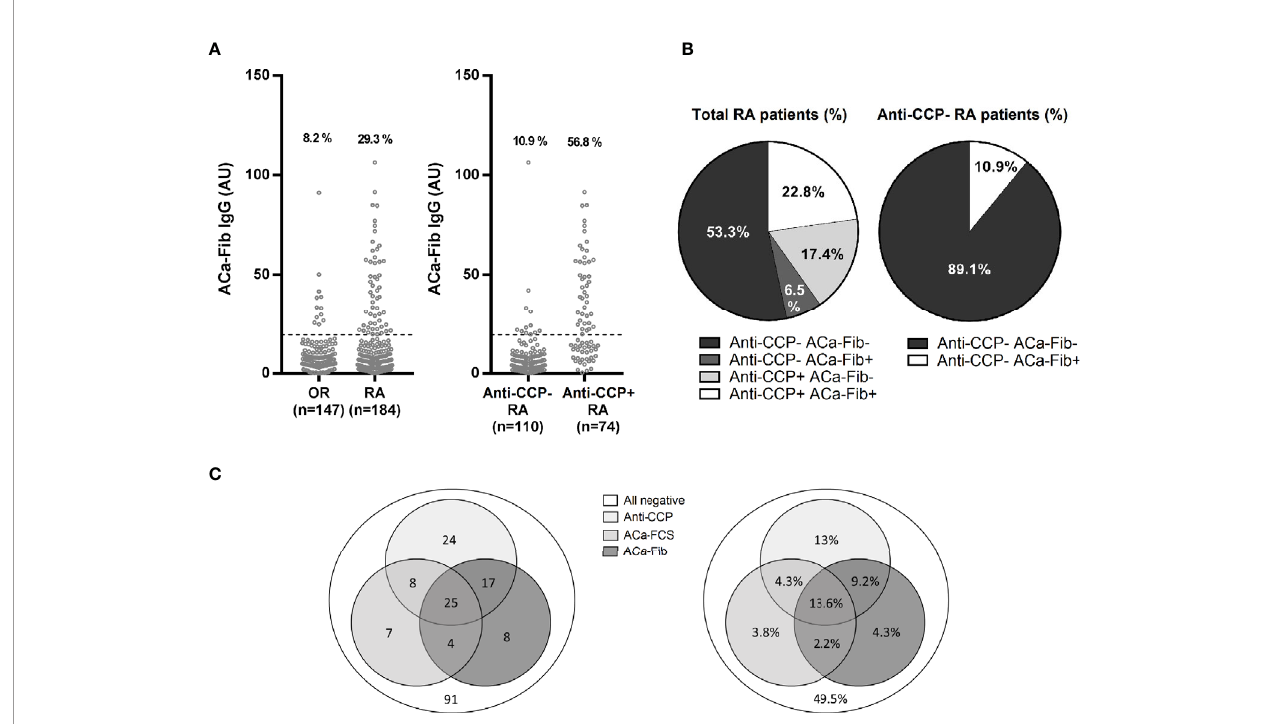
FIGURE 4 | Titer, prevalence and distribution of ACa-Fib and anti-CCP antibodies in the VErA cohort at baseline and distribution according to the triple status ACa- Fib, ACa-FCS, and anti-CCP antibodies. (A) ELISA test for detection of ACa-Fib IgG based on RA status (n=184) and other rheumatism (n=147) and anti-CCP antibodies status in RA patients (n=184). (B) Distribution of anti-CCP antibodies and ACa-FCS in RA patients from the VErA cohort. (C) Distribution of immunological pro fi le in RA patients considering triple status anti-CCP antibodies, ACa-Fib, ACa-FCS. Values are expressed in absolute numbers and percentages and represent the positivity of each auto-antibody. Anti-CCP, anti-cyclic citrullinated peptide antibodies; ACa-Fib, anti-carbamylated fi brinogen antibodies; ACa-FCS, anti- carbamylated fetal calf serum